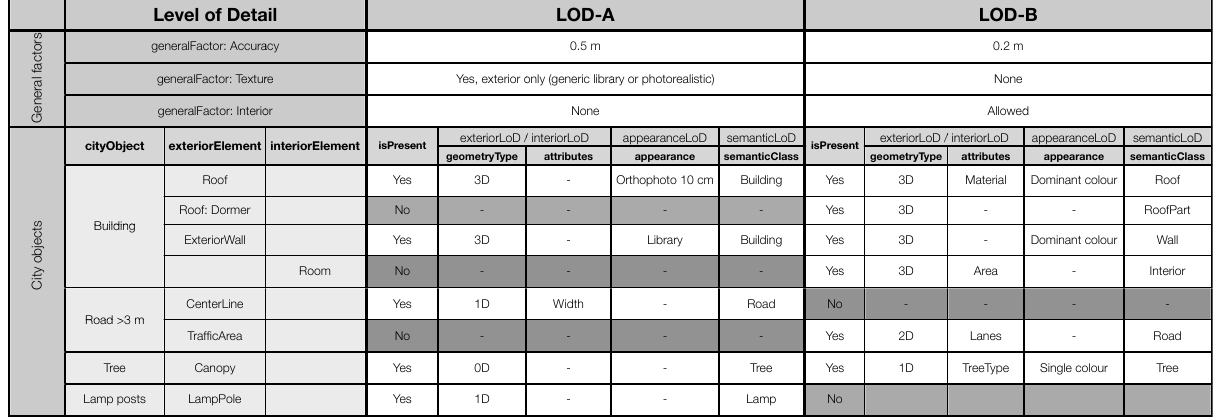
Figure 11: Example of a user requirement or company offer specification for two levels of detail of a 3D city